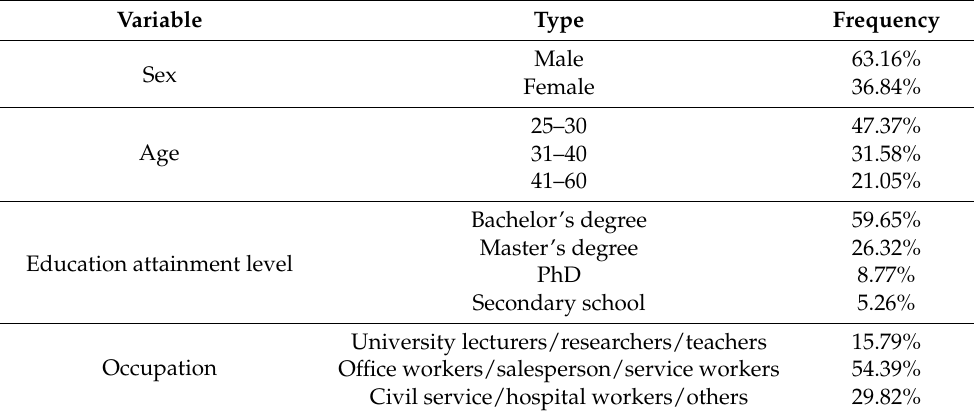
Table 2. Description of